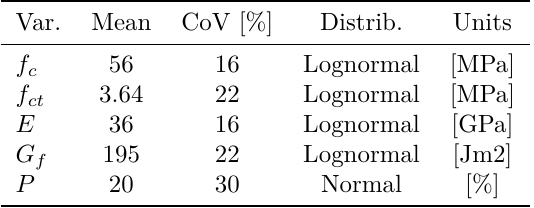
Table 1. Stochastic model of the numerical example.